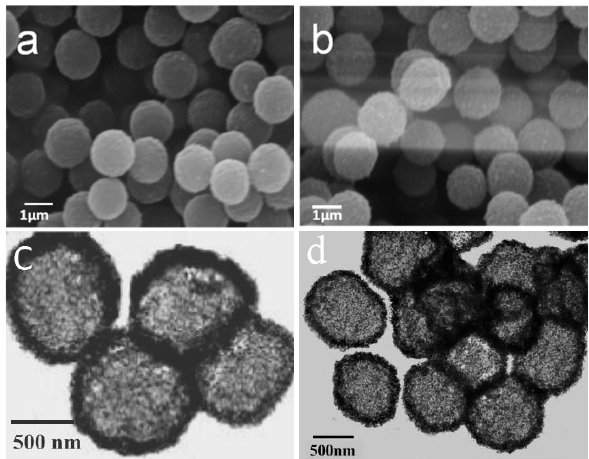
Figure 5. SEM images of MF@B-TiO 2 ( a ) and MF@P-TiO 2 ( b ) core–shell structures obtained with 3 vol % of TBOT ethanol solution and the TEM images of B-TiO 2 ( c ) and P-TiO 2 ( d ) hollow spheres derived from the corresponding core–shell structures by calcinations.